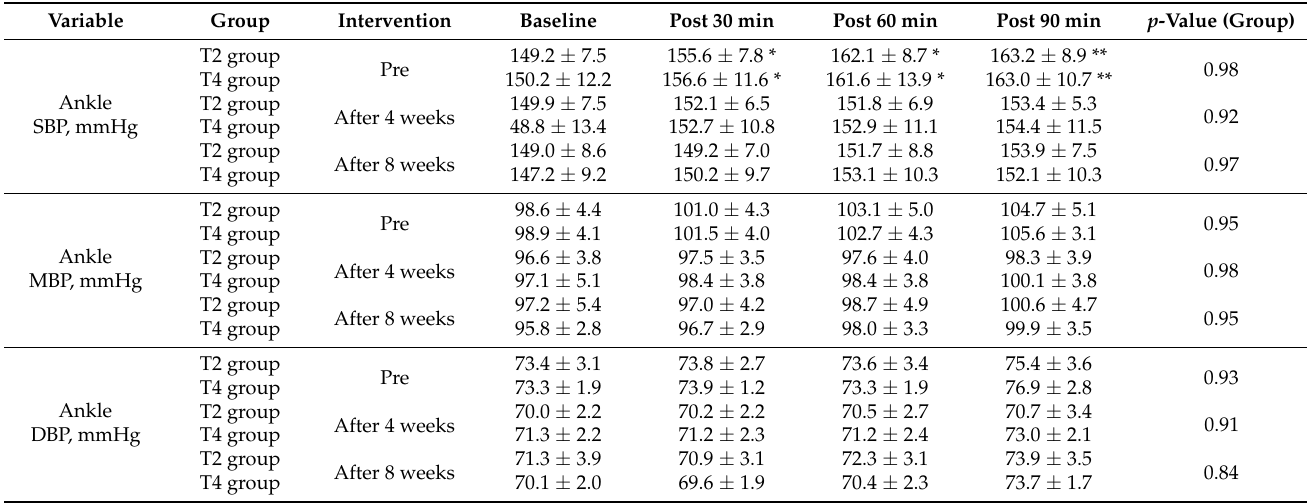
Table 3. Changes in ankle SBP, MBP and DBP before and after the 75-g OGTT of both groups.